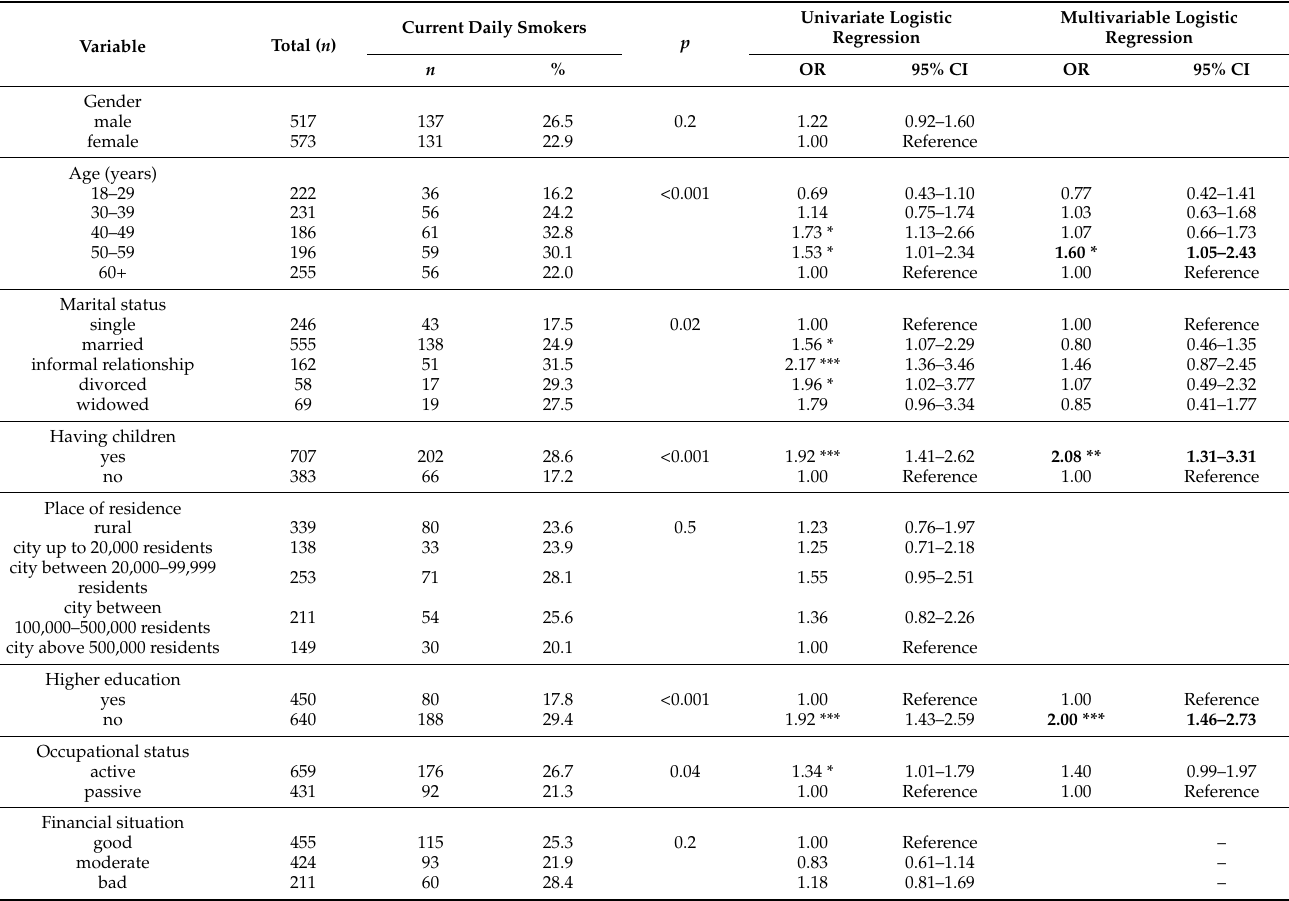
Table 3. Odds ratios (OR) and 95% confidence intervals (CI) for current daily smoking considering selected socioeconomic factors in a representative sample of adults in Poland, n =